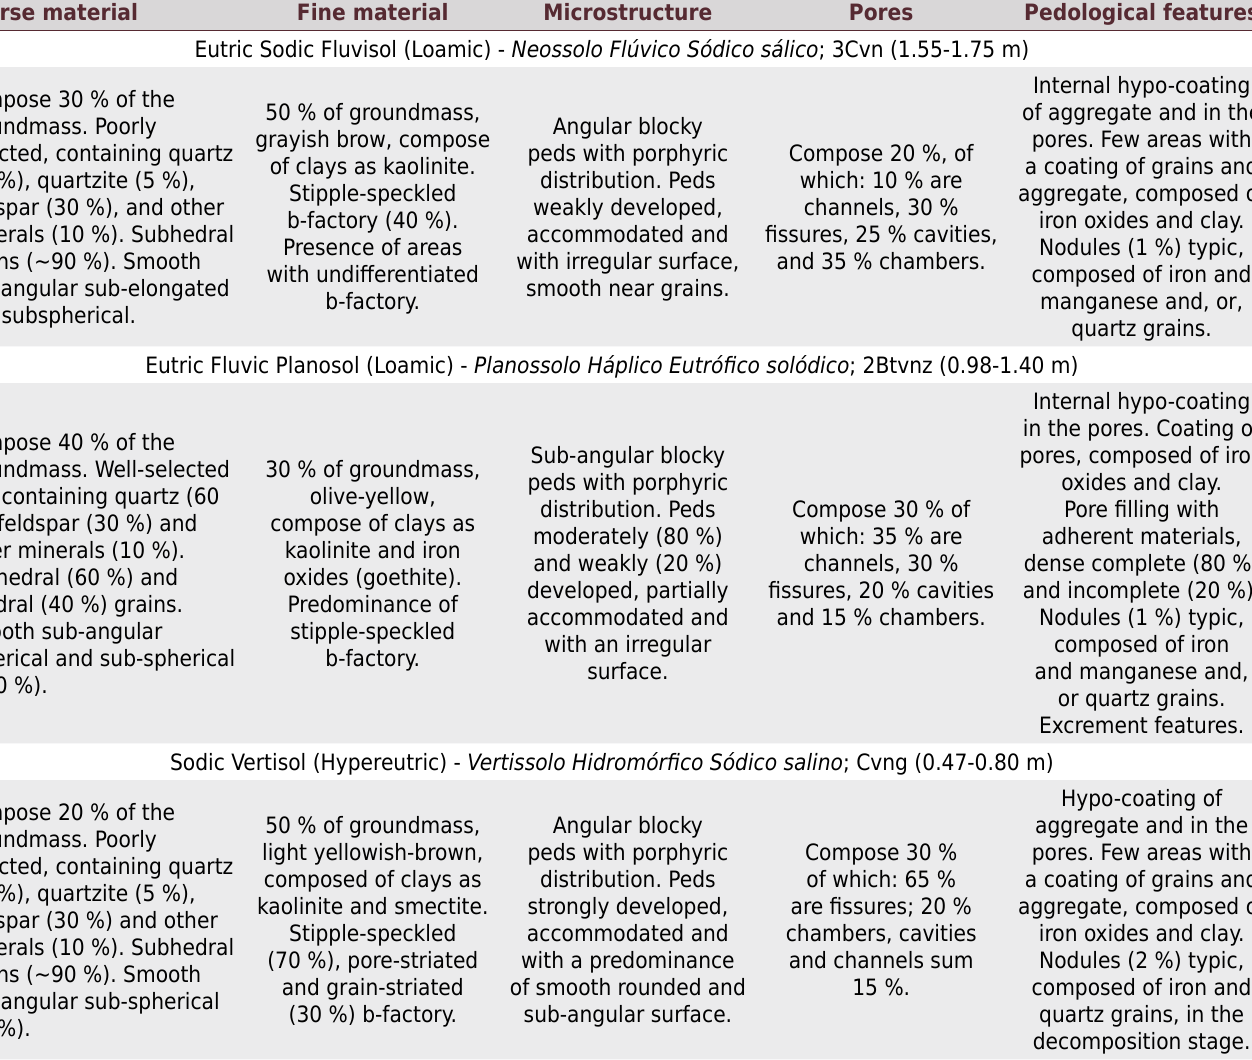
Table 6. Micromorphological description of selected horizons in soil profiles localized in lower course of the Acaraú River (Ceará State, Brazil) Coarse material Fine